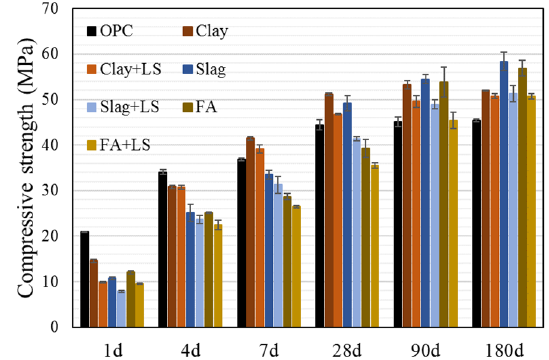
Figure 4. Comparison of strength development in binary and ternary mixes of Portland cement with either calcined clay, slag or fly ash without and with limestone